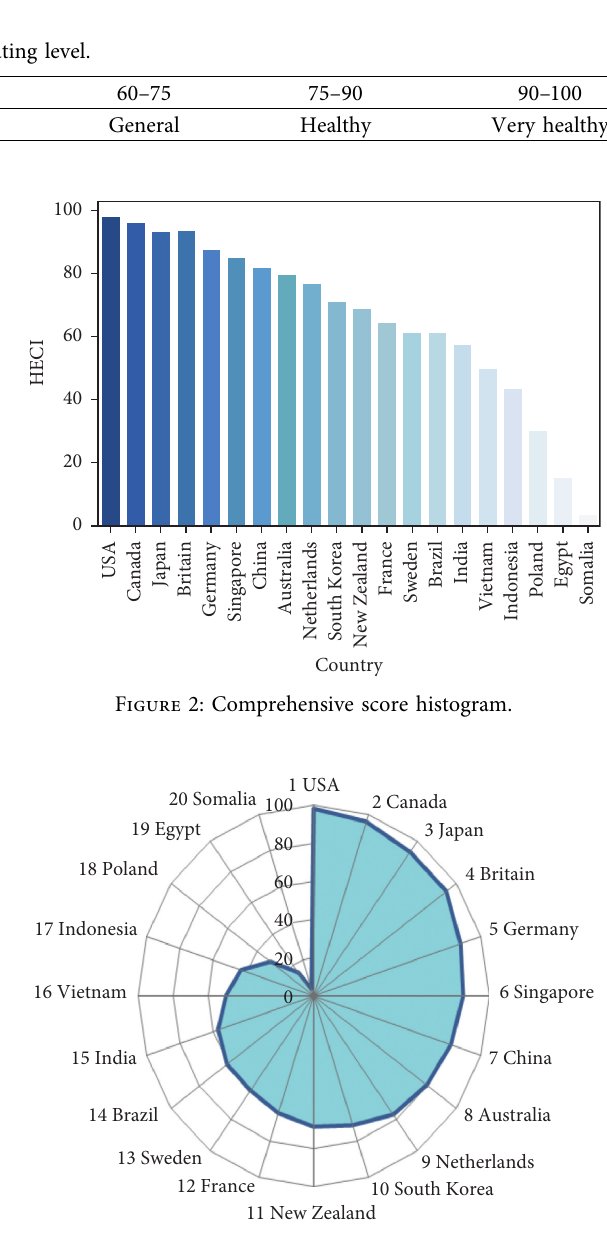
Figure 3: Comprehensive score radar